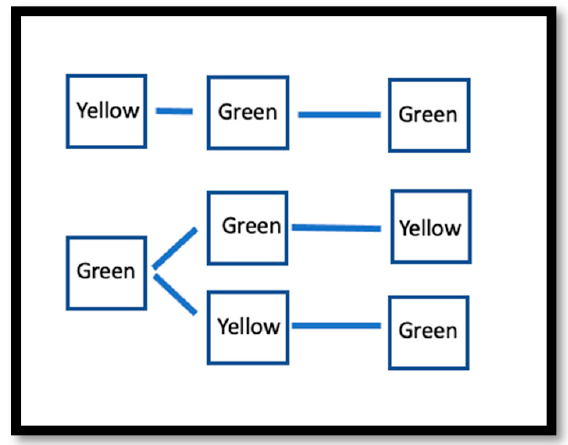
Figure 3. A tree with two colors follows the rule of sum of products.